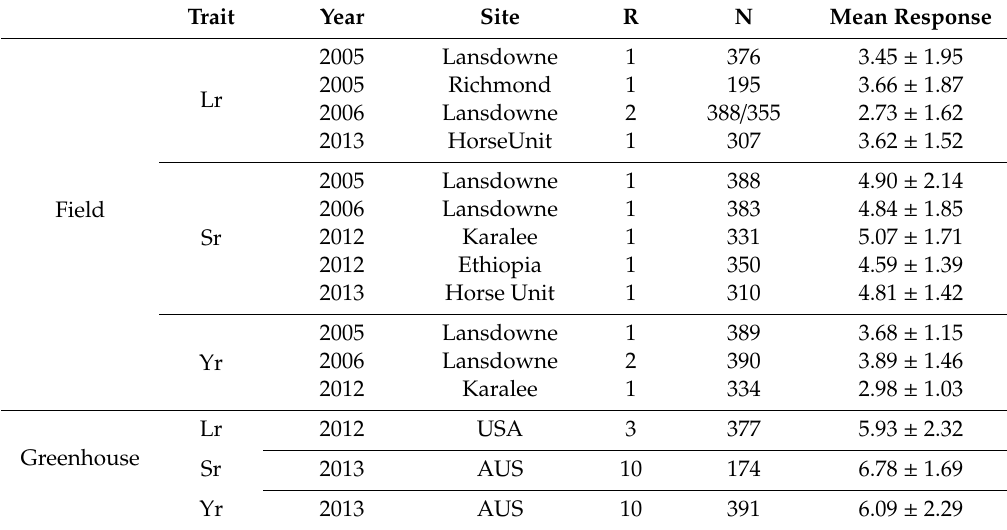
Table 1. Number of observation (N), number of replicates (R) and average resistance response ( ± ) standard deviations for leaf rust (Lr), stem rust (Sr) and stipe rust (Yr).